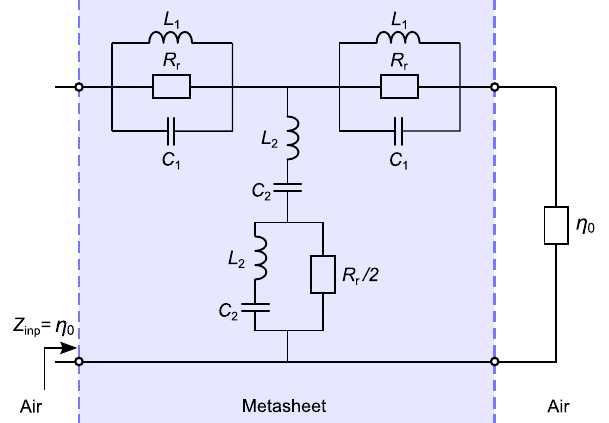
FIG. 7. An equivalent circuit of the proposed absorbers matched at all frequencies. The resistive load η 0 ¼ 377 Ω denotes the impedance of free space behind the absorber.